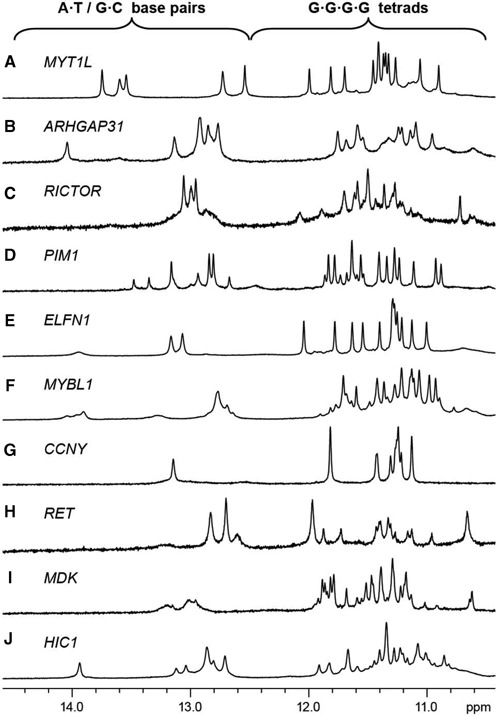
One-dimensional (1D) imino proton NMR spectra of SLQS identified across various genes in the human genome. Gene names for which the respective SLQS have been located within are indicated. Typical chemical shift ranges for imino protons participating in the formation of Watson–Crick base-pairs (A•T/G•C) and G-tetrads (G•G•G•G) are demarcated. (A) G4ST02001786748, (B) G4ST03120547683, (C) G4ST05039110287, (D) G4ST06037246104, (E) G4ST07001717478, (F) G4ST08067688172, (G) G4ST10035665408, (H) G4ST10042891022, (I) G4ST11046359281 and (J) G4ST17001906030.